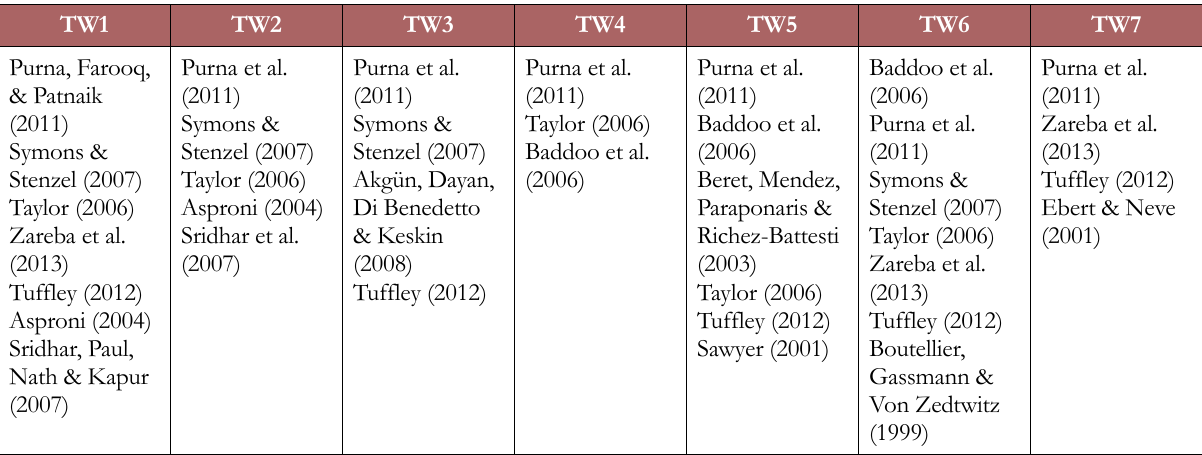
Table 10. FINCODA Team Work and supporting